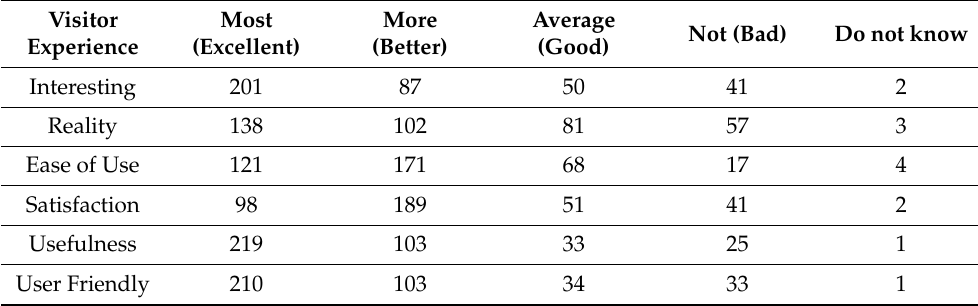
Table 5. Statistics collected from different visitors.